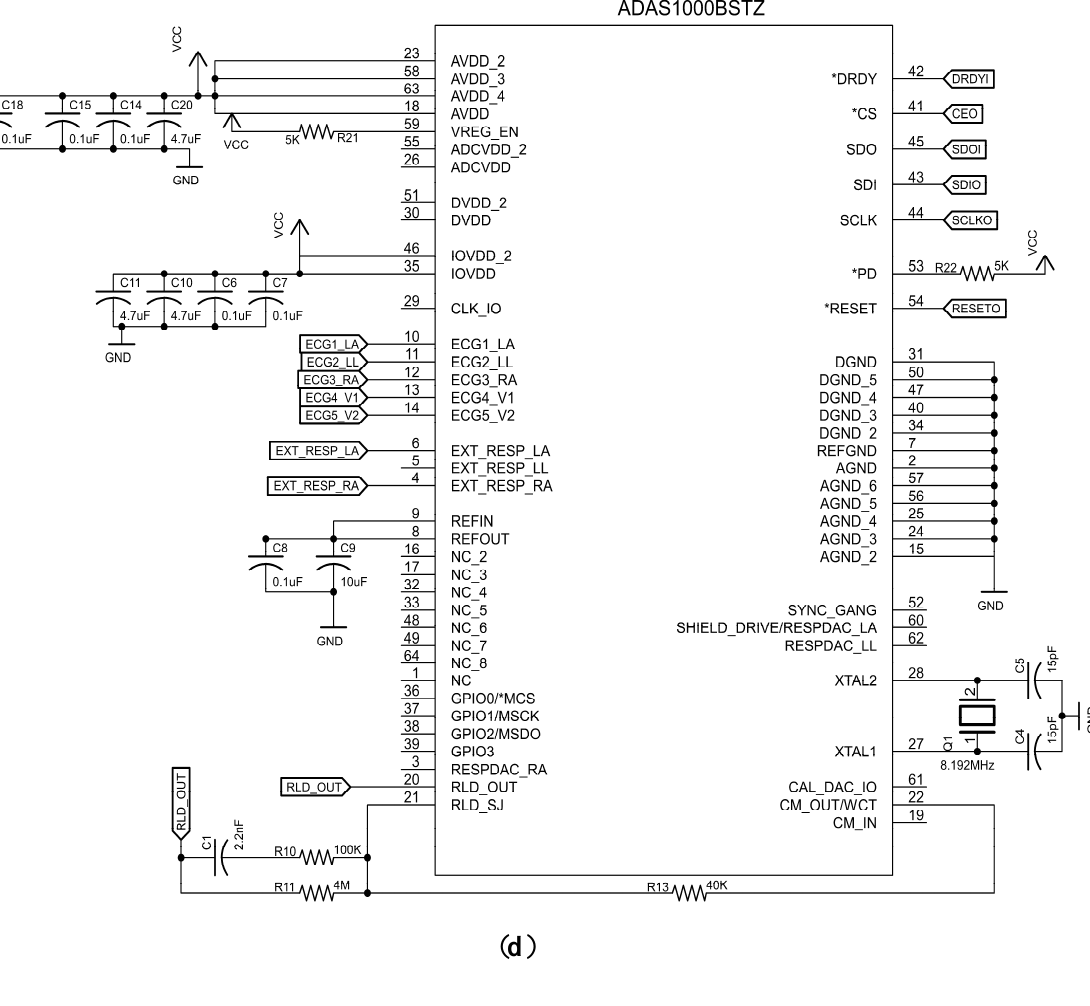
Figure 4. Schematic diagrams of prototype. GPIO Connector of Raspberry PI ( a ), Insulation layer for DC and SPI Communication using ADuM chips ( b ), ESD protection of ECG/external respiratory path by using SP720 ( c ) and ADAS1000 ( d